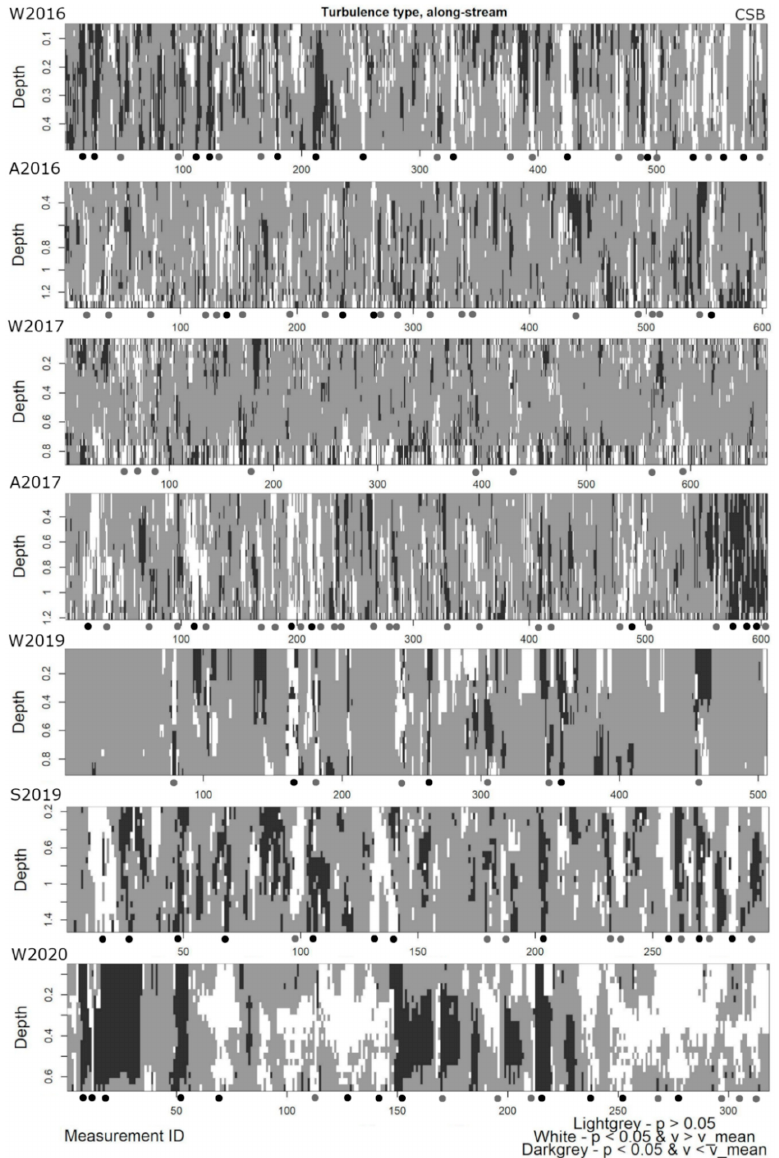
Figure 7. The results of the LISA analysis at CSB during all measurement times based on streamwise velocity. The S2017 and W2018 results can be seen from Figures 3 and 4. Measurement ID means the sample numbers ( n ), and therefore also represents seconds. Note that the S2019 and W2020 measurements were shorter in time. The black dots indicate the occurrence times of statistically significant strong high and low flow wedges reaching from the surface to the riverbed, and the grey dots indicate the times when there is weaker wedge (i.e., cluster has broken with a few cells within the vertical water column).